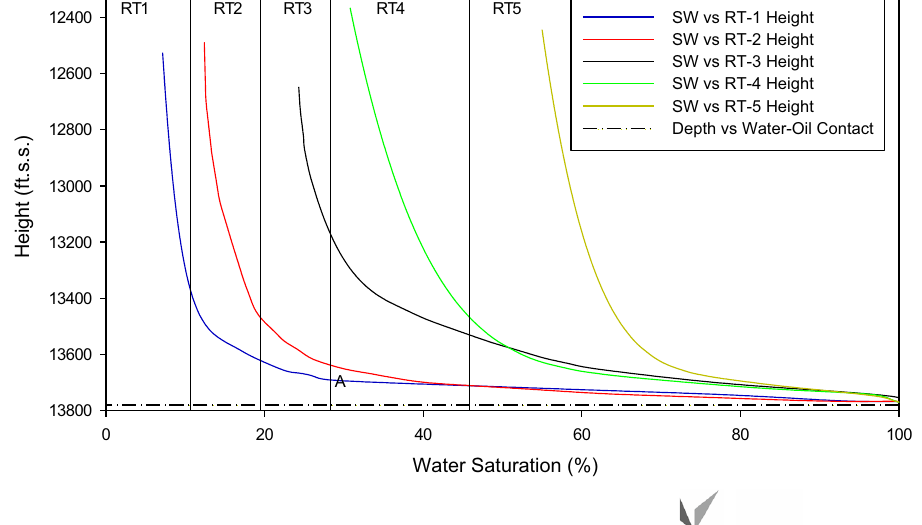
Fig. 2 Sketch of rock typing with fix ranges of irreducible water saturation. Point “A” located in the transition zone must be classified as rock type 1 rather than rock type 4